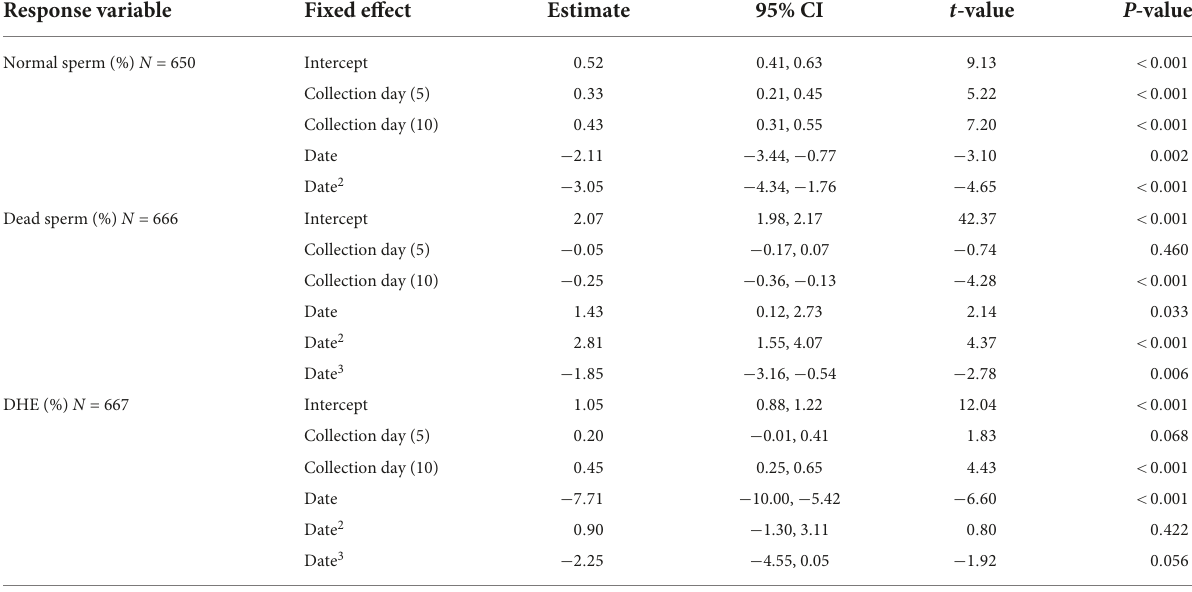
TABLE 2 Selected parsimonious linear mixed models exploring the effect of male and sperm age on the percentage of normal, dead, and DHE positive sperm. Response variable